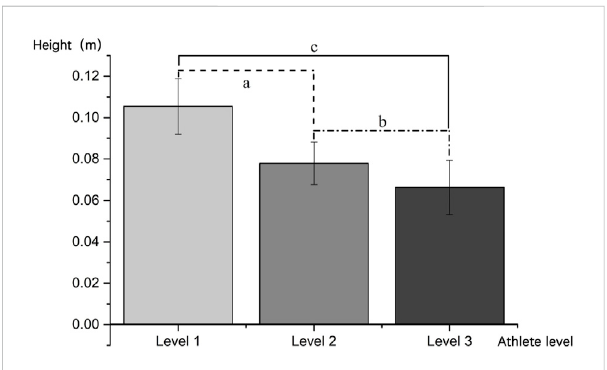
FIGURE 5 FUS ’ s fl ying height of level 1, level 2, and level